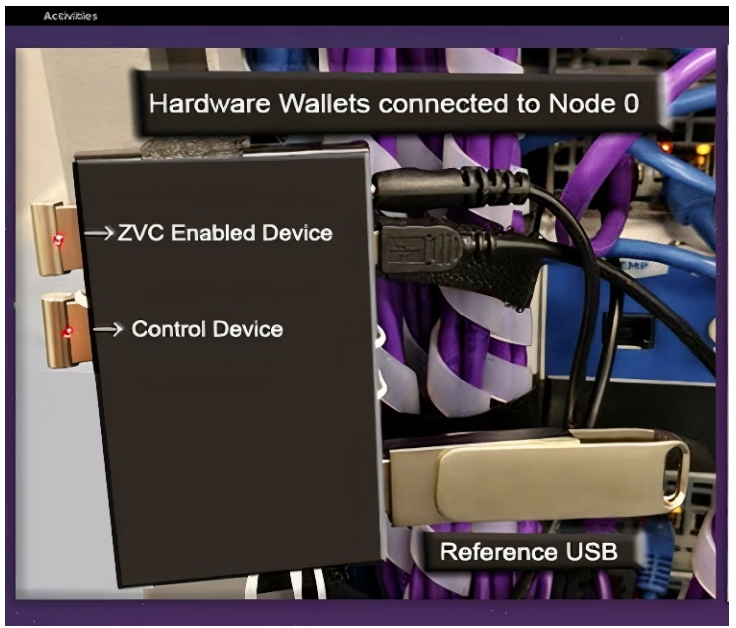
Figure 9. Visual depiction of the test device, the control device, and the reference device mounted on Node0 (target node).